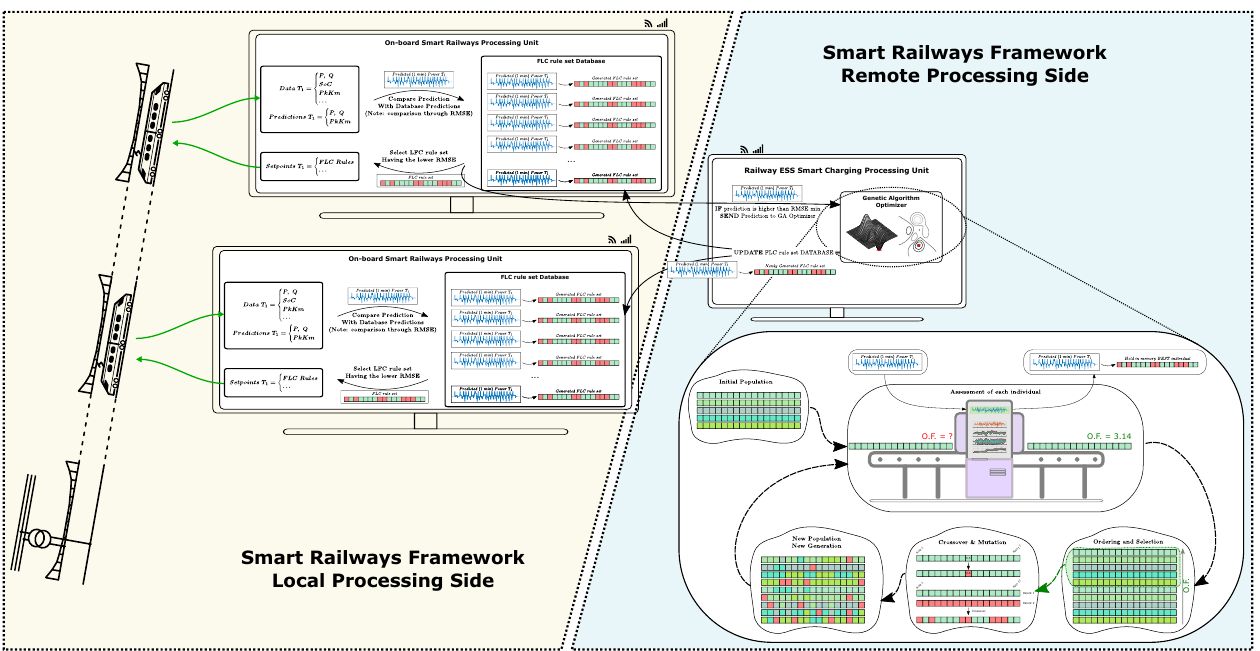
Figure 17. Illustration on the information flow between local and remote processing